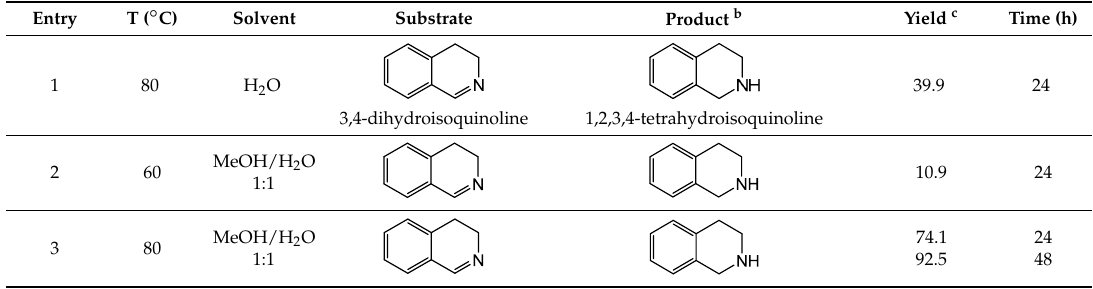
Table 2. Catalytic transfer hydrogenation of cyclic imines with 3 a .